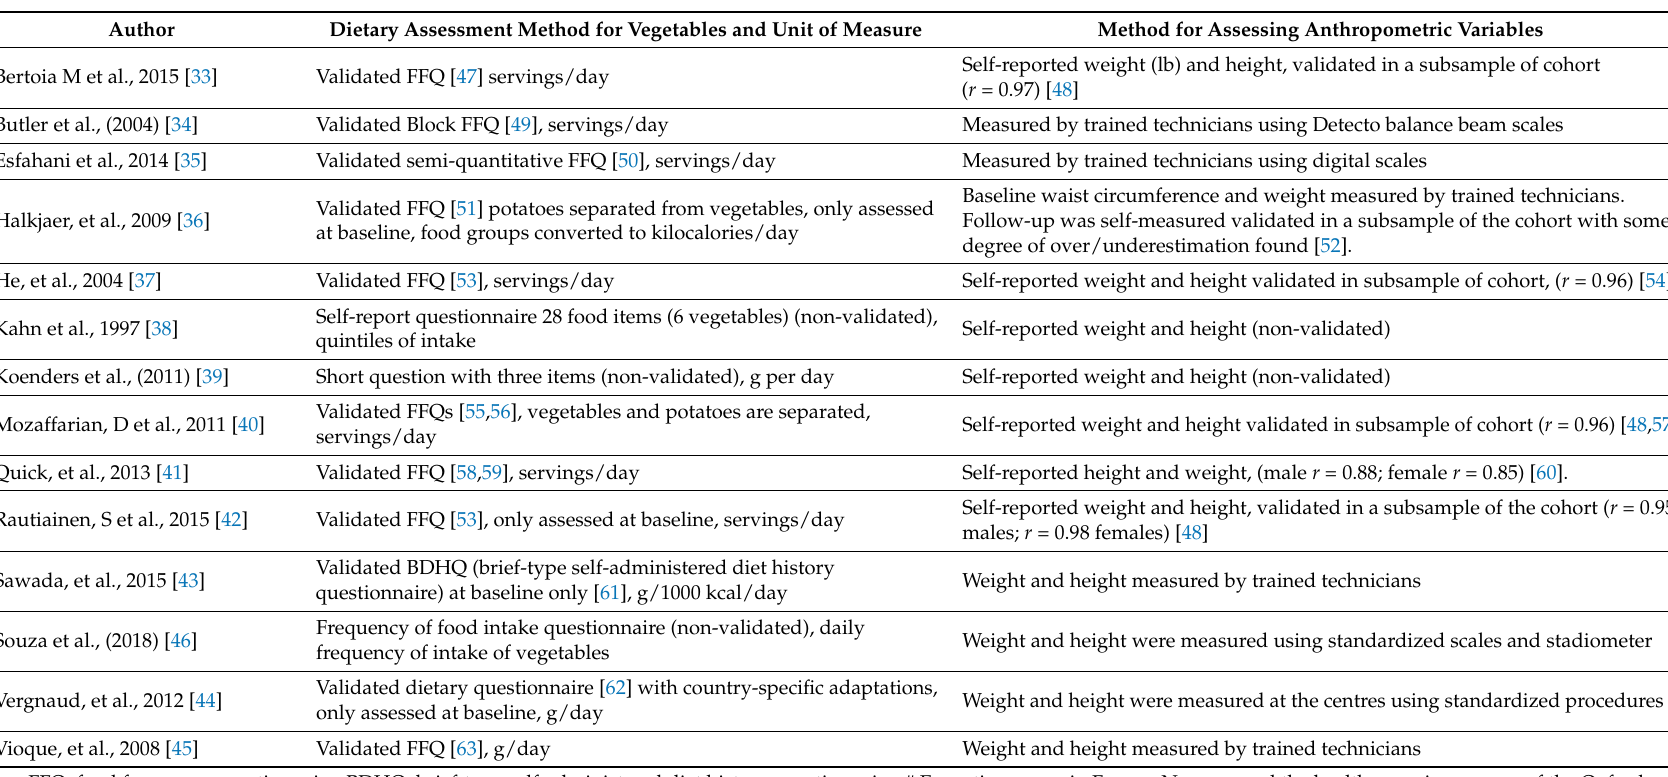
Table 3. Validity of methods for dietary assessment and measure of anthropometric